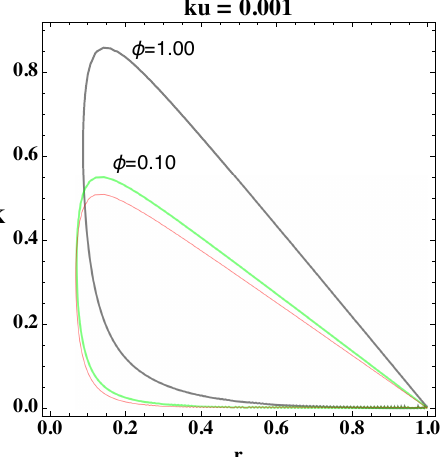
Figure 2. Diagram in parameter space of the PAH bifurcation boundaries with k u =